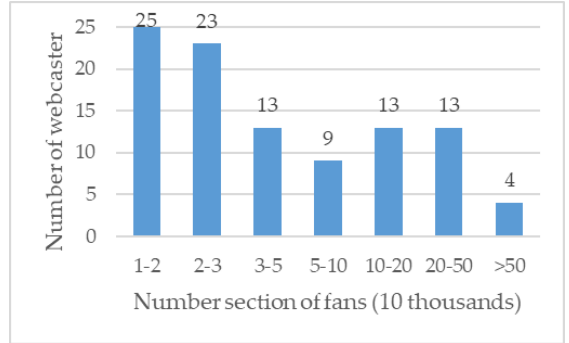
Figure 19. Sectional statistical chart of the fans of the 100 webcasters.